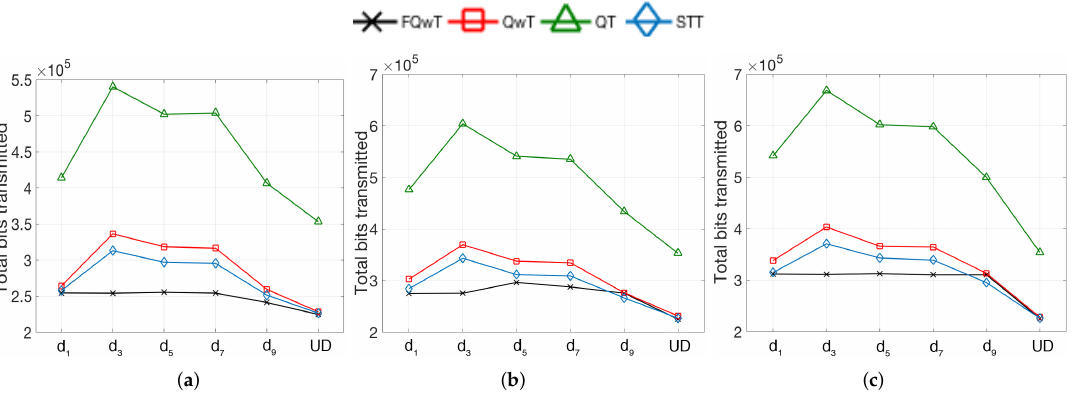
Figure 13. Simulation results obtained for total transmitted bits for different tag subdistributions when BV varies from 0% to 100%; FPL is 20, 60 and 100; and, d m varies from d 1 to UD. ( a ) FPL = 20; ( b ) FPL = 60; ( c ) FPL =